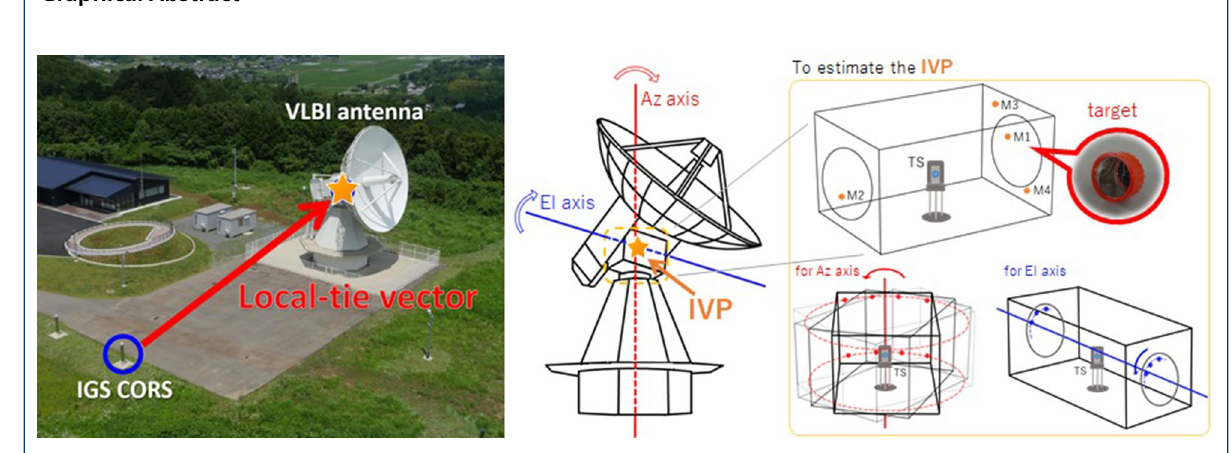
the position is invisible and inaccessible. In the back- ground, the methods to indirectly estimate the IVP have been developed (Woods 2008). The methods are cat- egorized into two types in this study, inside method and outside method. In the outside method, a target mirror